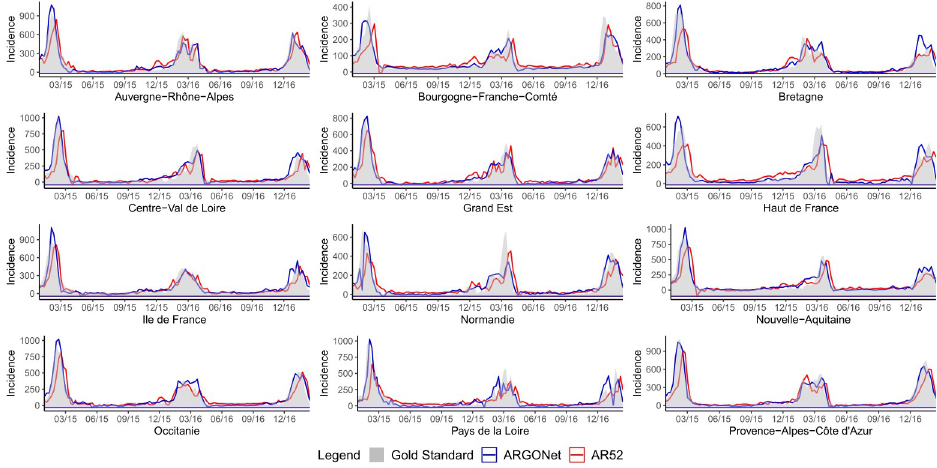
Fig 7. Real-time estimate obtained with ARGONet and AR(52) models from January 2015 to March 2017.